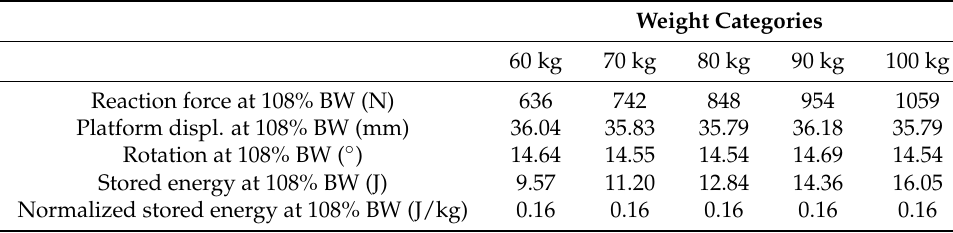
Table 3. Static tests results (dorsiflexion) and stored elastic